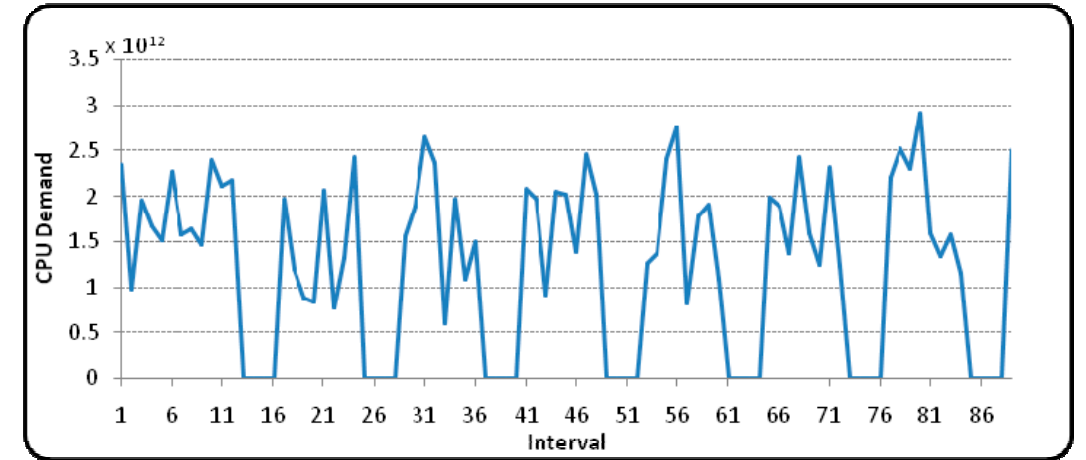
Figure 11. Generated processor demand with request migration cycles .